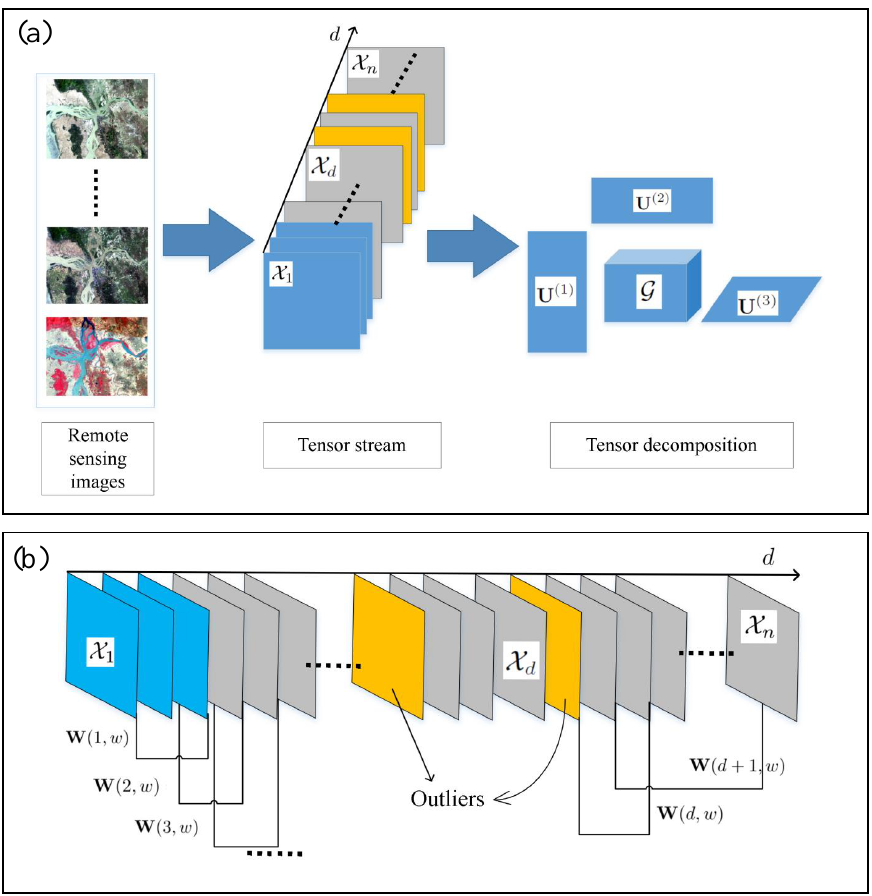
Figure 2. Tensor and sliding-window-based tensor stream analysis (The process of tensor stream con- struction and tensor decomposition are presented in ( a ), and ( b ) shows the process of reconstructing outlier based on SWTSA. X d , W ( d , w ) and U ( i ) represent the tensor, sliding window and the factor matrix,